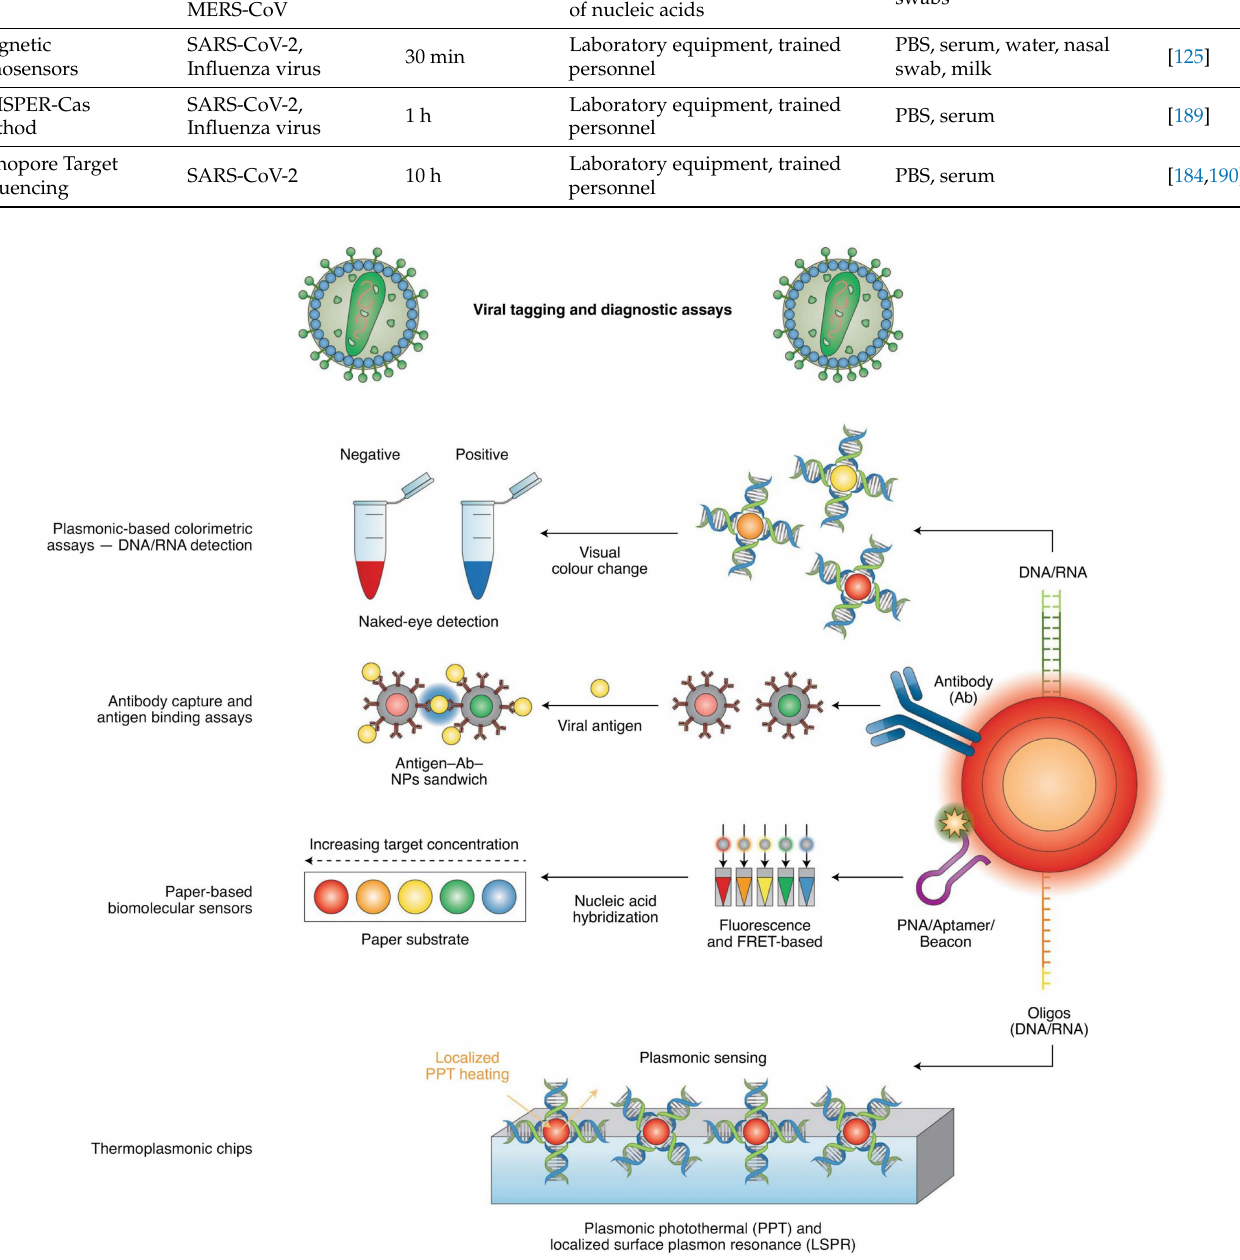
Figure 9. Detection based on colorimetric, antigen binding as well as light and photothermal plat- forms strategy by nanomaterials engineered with nucleic acids or antibodies is nano-based diagnostic main lines. Reproduced with permission from [191]. Copyright Royal Society of Chemistry,